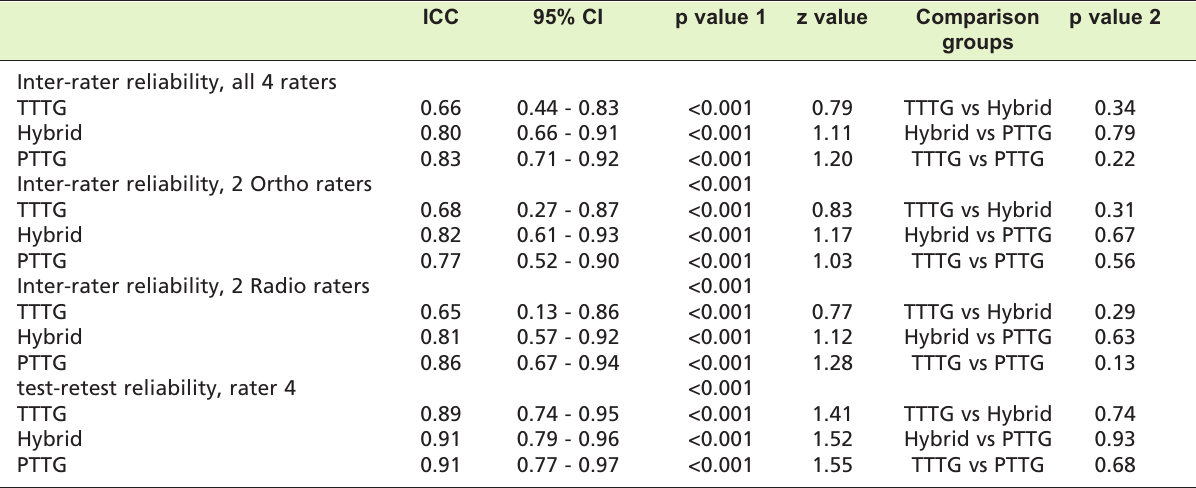
ICC for inter-rater and test-retest reliabilities for the PFI group Table IV: